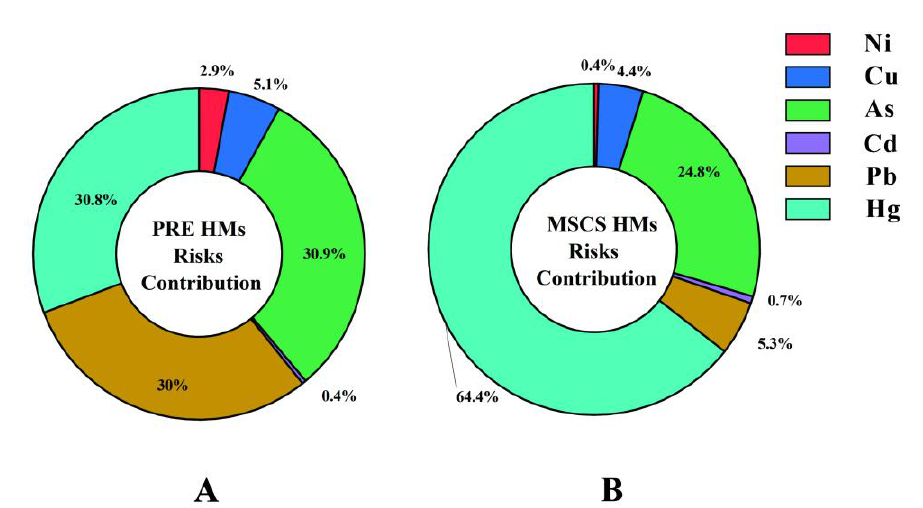
Figure 4. Comparison of target hazard quotient (THQ) and relative contribution of 6 analyzed heavy metals (HMs) in the Pearl River Estuarine (PRE, ( A )) and the middle of the South China Sea (MSCS, ( B )) fish.